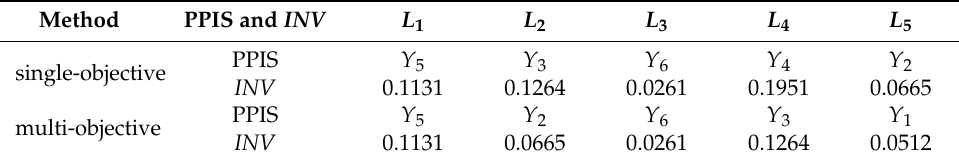
Matching results and INV comparison for single-objective optimization model and multi-objective optimization